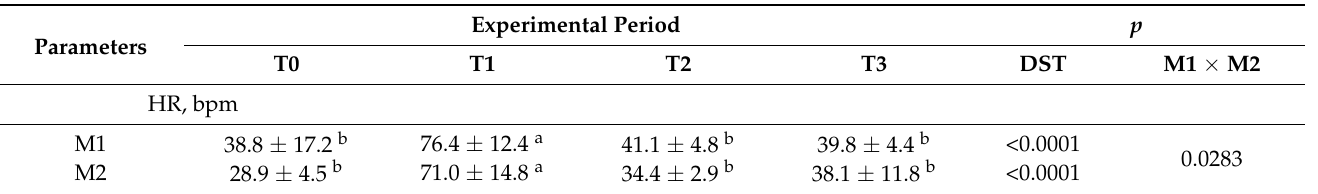
Table 3. Heart rate measured in the dressage simulation tests used to evaluate a 6-week training protocol for Lusitano horses.